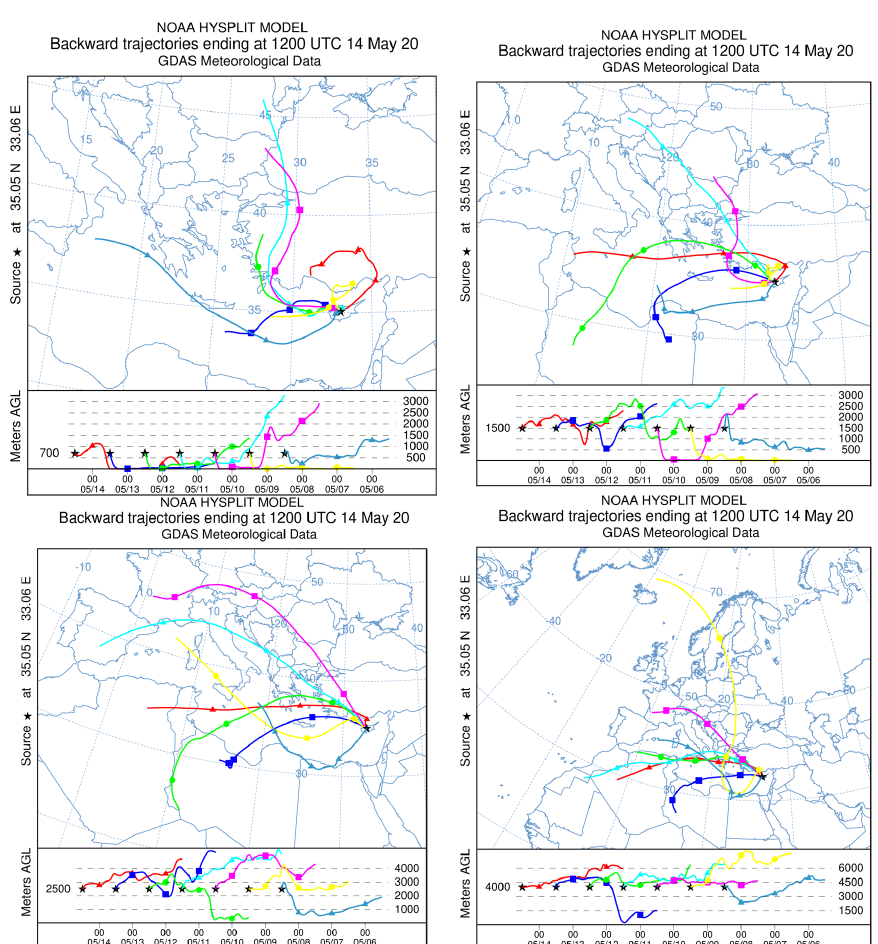
Figure 14. The air mass back trajectories from 06/05 to 14/05/2020 for the area of AURA station and AGM at elevations of 700 m,1500 m, 2500 m, 4000 m above sea level. The asterisk denotes the 72-h back-trajectory origins at 12:00 UTC of the respective date.